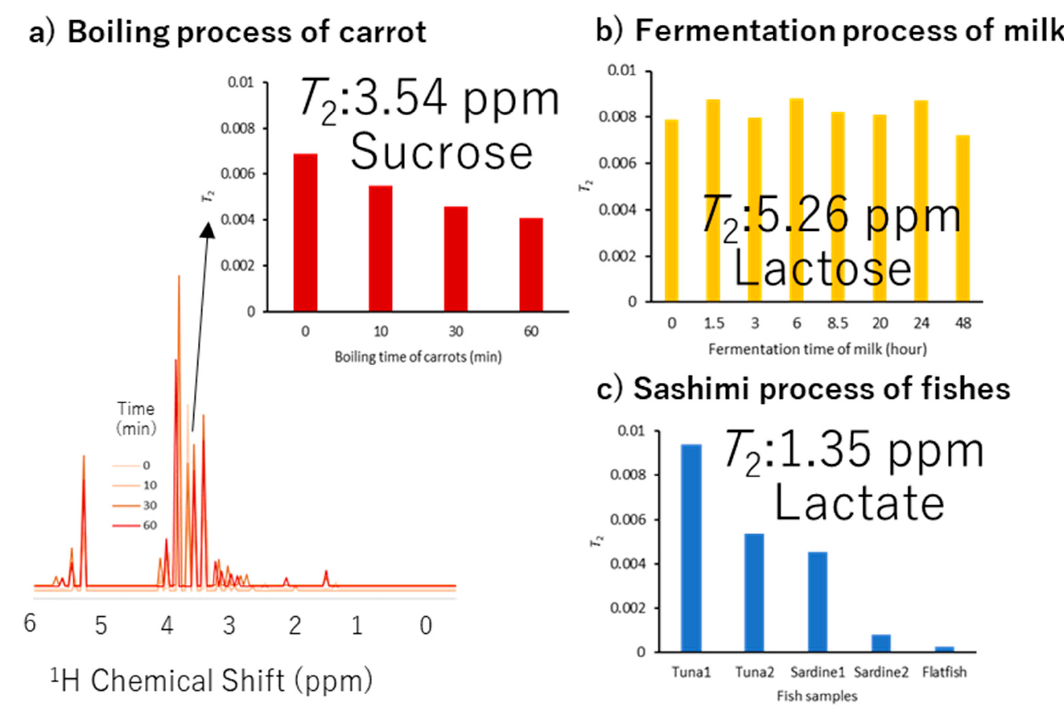
Figure 2. Parameter visualization of 1 H NMR spectra involved in primary industry processes. An example of parameter visualization about chemical shift and T 2 for NMR datasets for fisheries, livestock, and agriculture is shown. ( a ) NMR dataset of the boiling process of carrots in agriculture. ( b ) NMR dataset of the fermentation process of milk in the livestock industry. ( c ) NMR dataset of sashimi process of fishes (tuna, sardine, and flatfish) in the fishery industry.